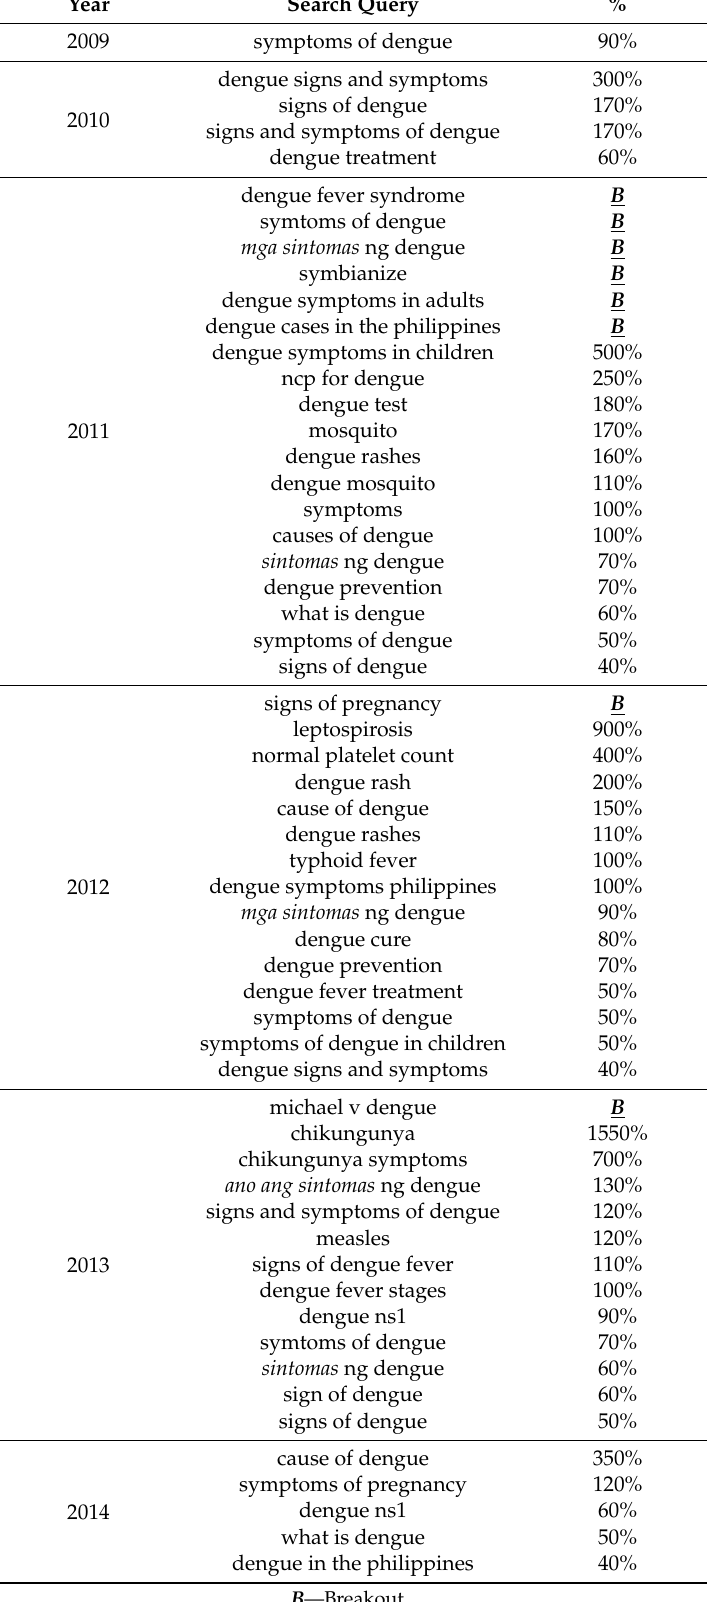
Table 3. Rising and breakout search queries related to dengue from 2009–2014 in Metropolitan